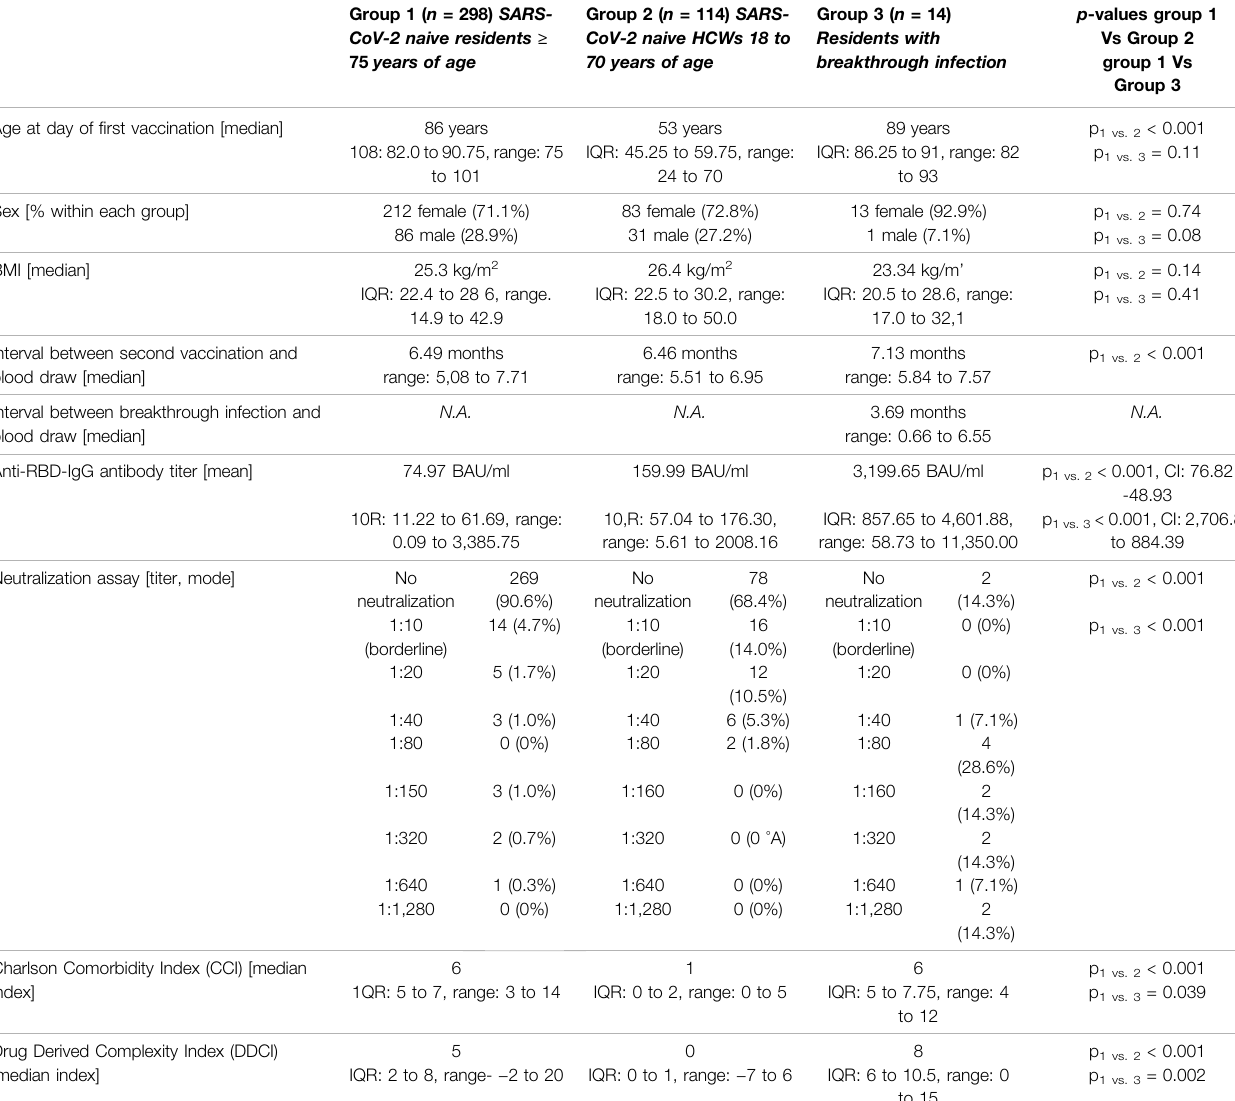
TABLE 1 | Cohort characteristics by study group. Wilcoxon rank sum test was used to test for homogeneity between study groups. The p -values can be found in column 5